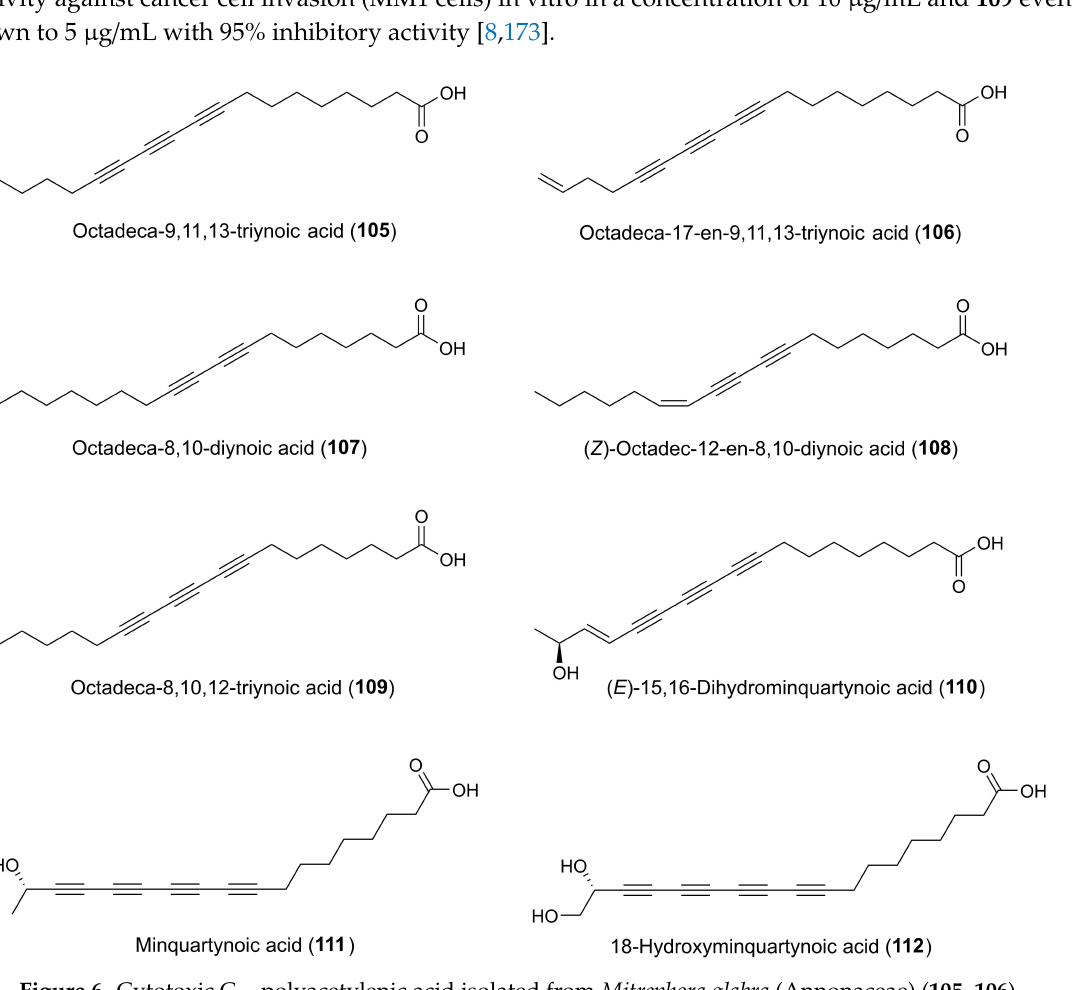
Figure 6. Cytotoxic C 18 polyacetylenic acid isolated from Mitrephora glabra (Annonaceae) ( 105 , 106